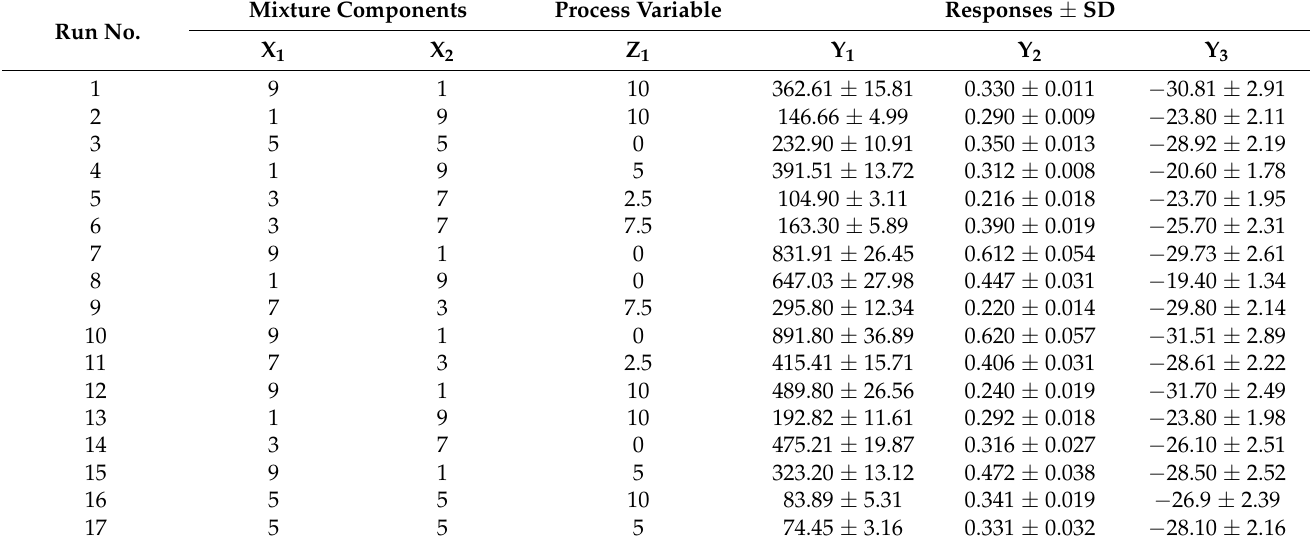
Table 2. Composition and observed responses of experimental runs of SMV-SPNs prepared according to the combined mixture–process variable D-optimal design.